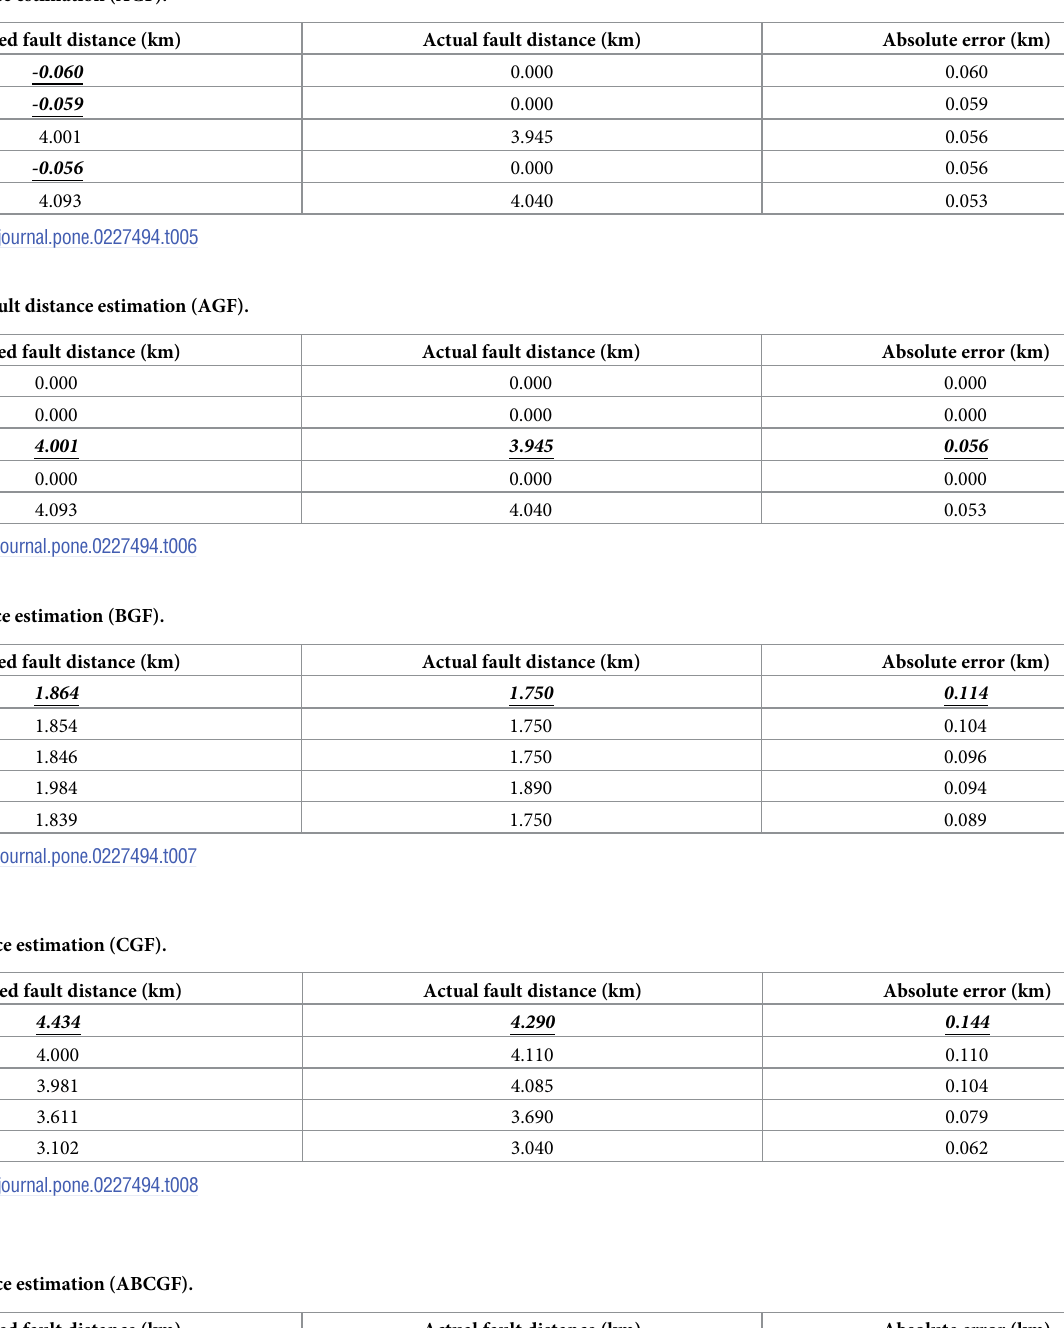
Table 5. Fault distance estimation (AGF).